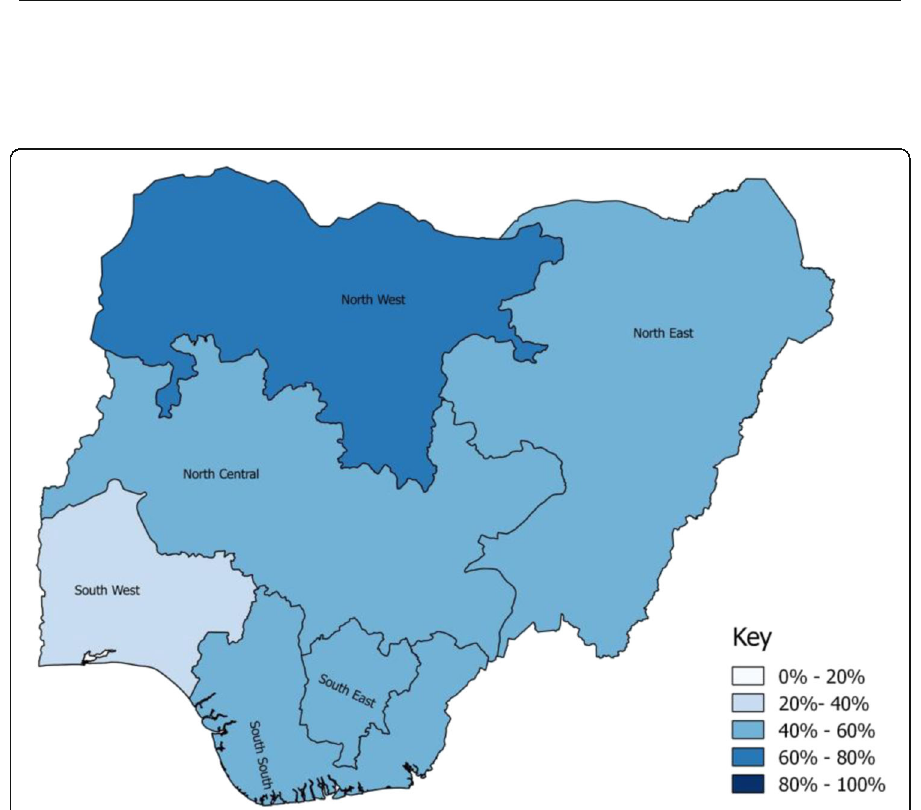
Fig. 7 Percentage of women believing that a husband is justified in beating his wife for any reason, by region, NDHS